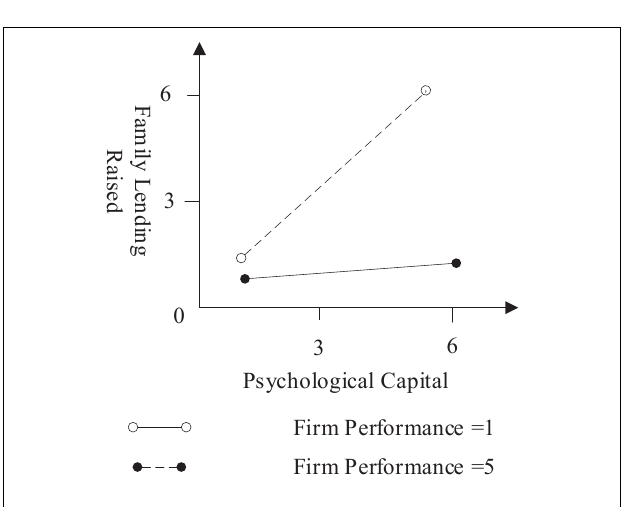
FIGURE 3 | The moderator of firm